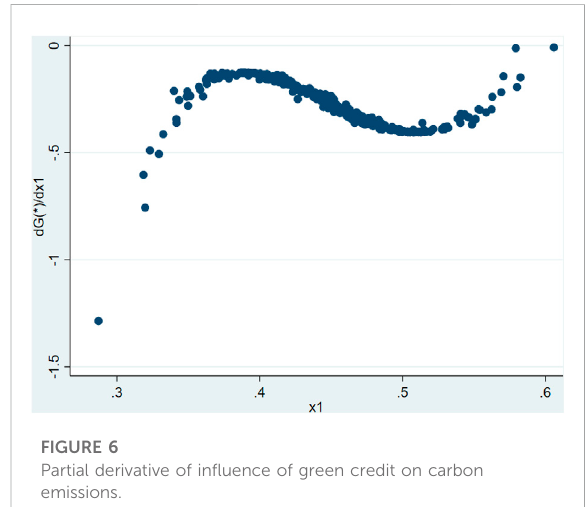
TABLE 10 Spatial measurement results based on geographical distance weight